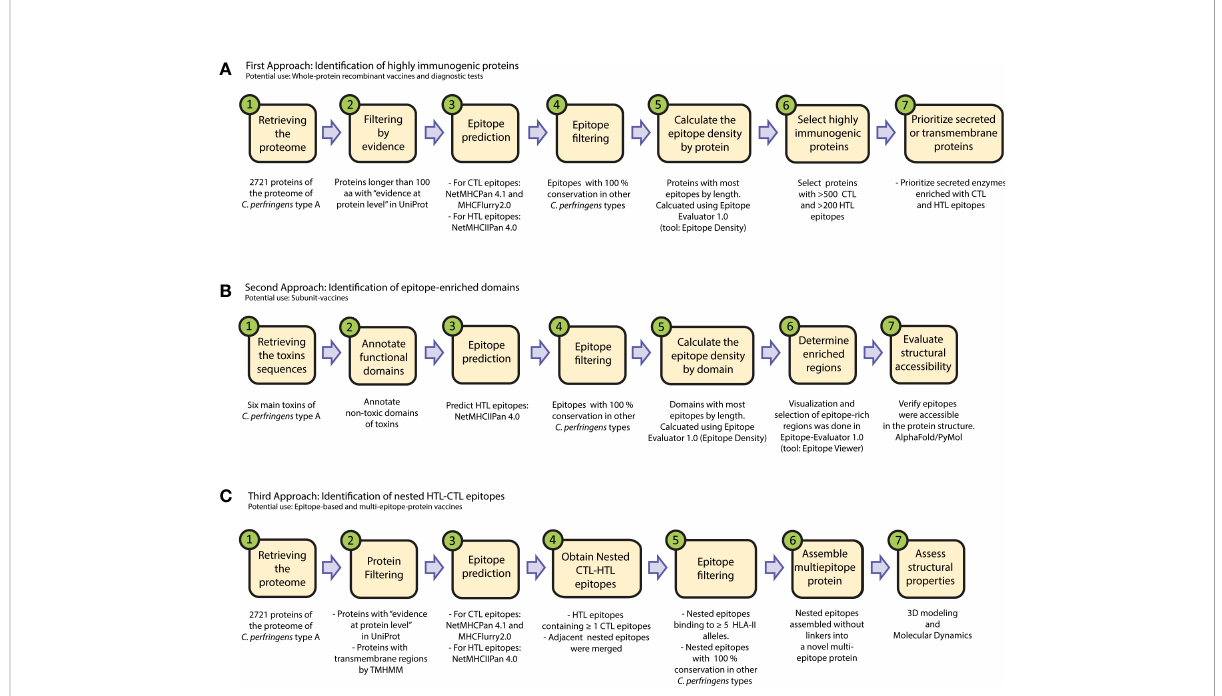
FIGURE 1 Flowchart of the immunoinformatic exploration of pathogens for vaccine development. We present three work fl ows to identify: (A) immunogenic proteins for protein-based vaccines, (B) protein domains enriched in HTL epitopes for subunit vaccines, and (C) nested epitopes for the design of novel multi-epitope protein vaccines. The proteins obtained in these three approaches might be used as well in immunodiagnostic